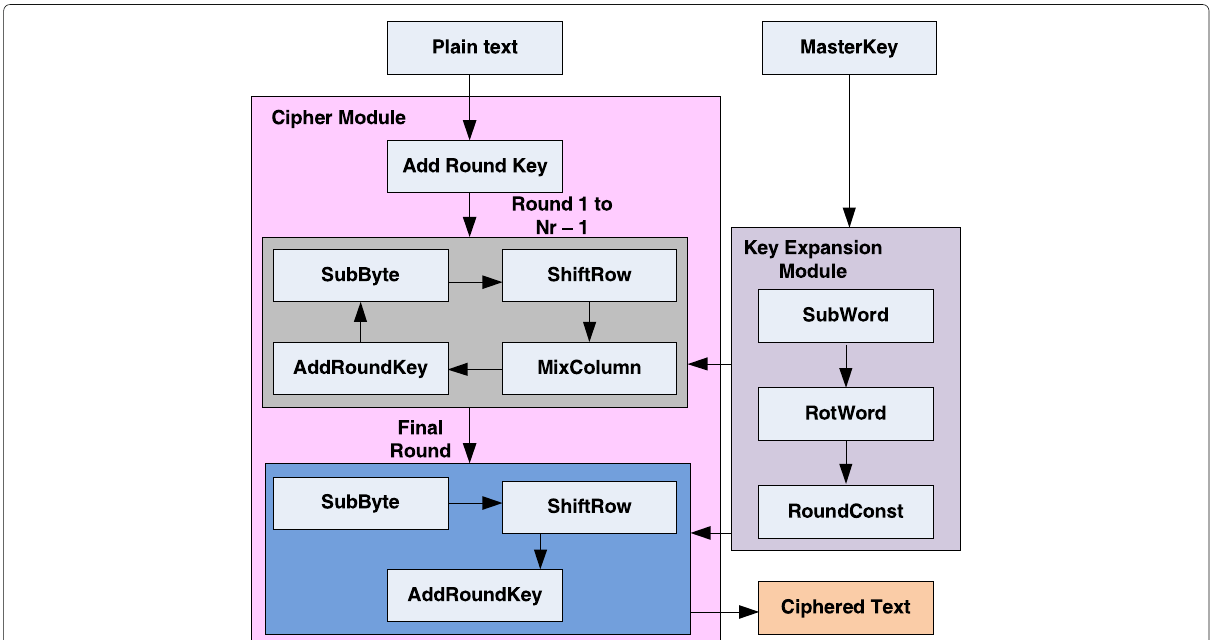
Fig. 3 An overview of standard AES implementation with different modules and